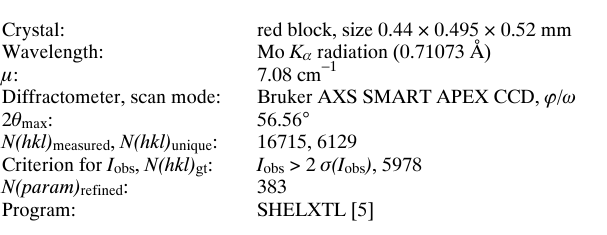
Table 4. D a t a collection a nd h a ndling.